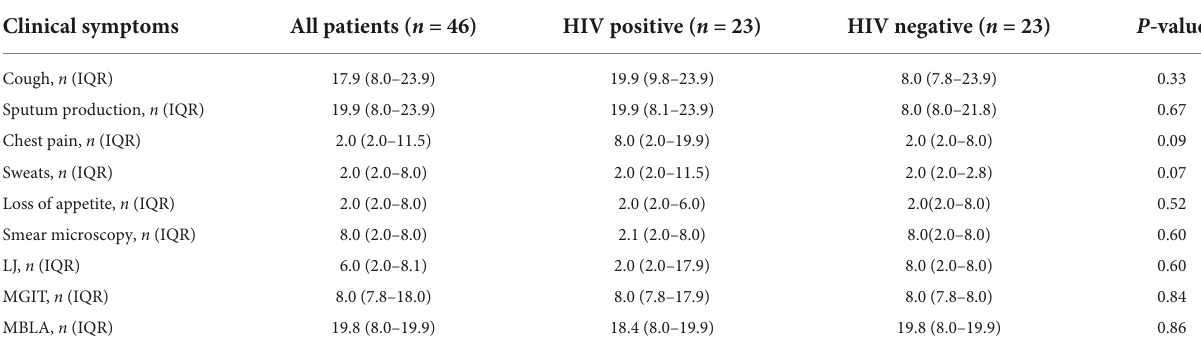
TABLE 4 Time to the resolution of TB symptoms and bacteriological tests stratified by HIV status. Median time to resolution of clinical symptoms (weeks) Clinical